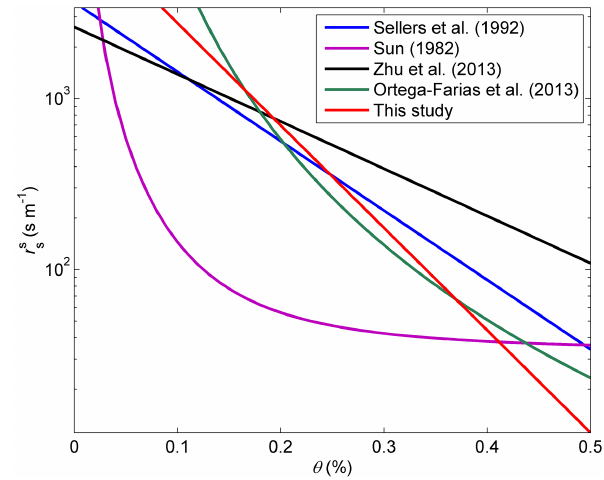
Figure 6. Comparisons of responses of soil surface resistance ( r s s ; sm − 1 ) to soil surface water content ( θ ; %)